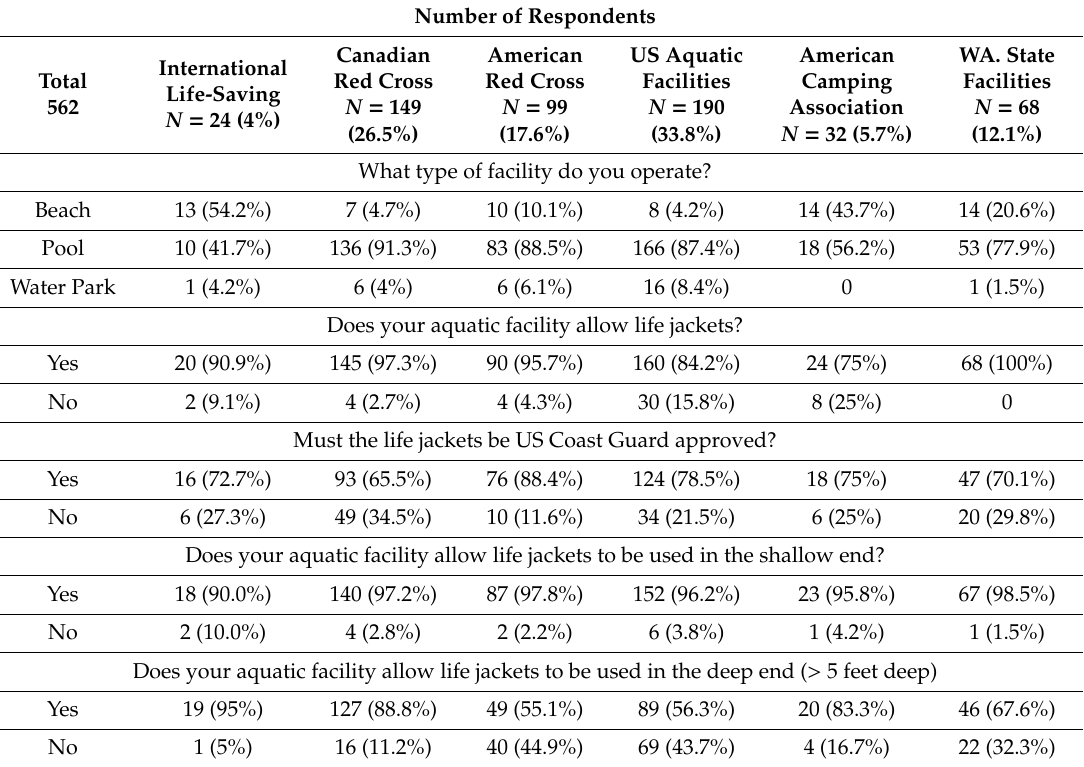
Table 1. Survey responses by major organizations / groups